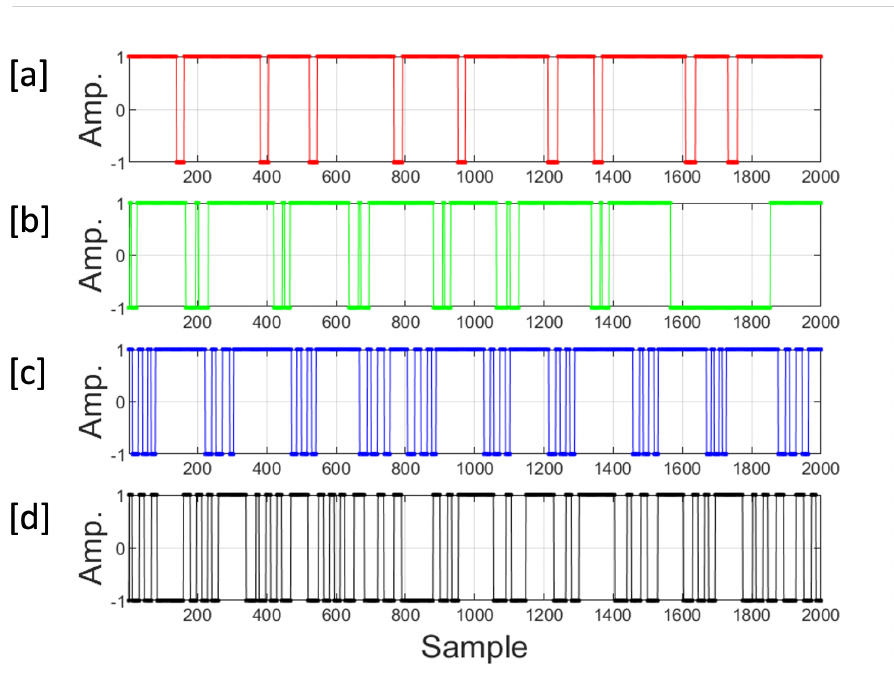
Figure 8. Pre-processed signal from top: ( a ) 1-finger, ( b ) 2-finger, ( c ) 3-finger, and ( d ) 4-finger